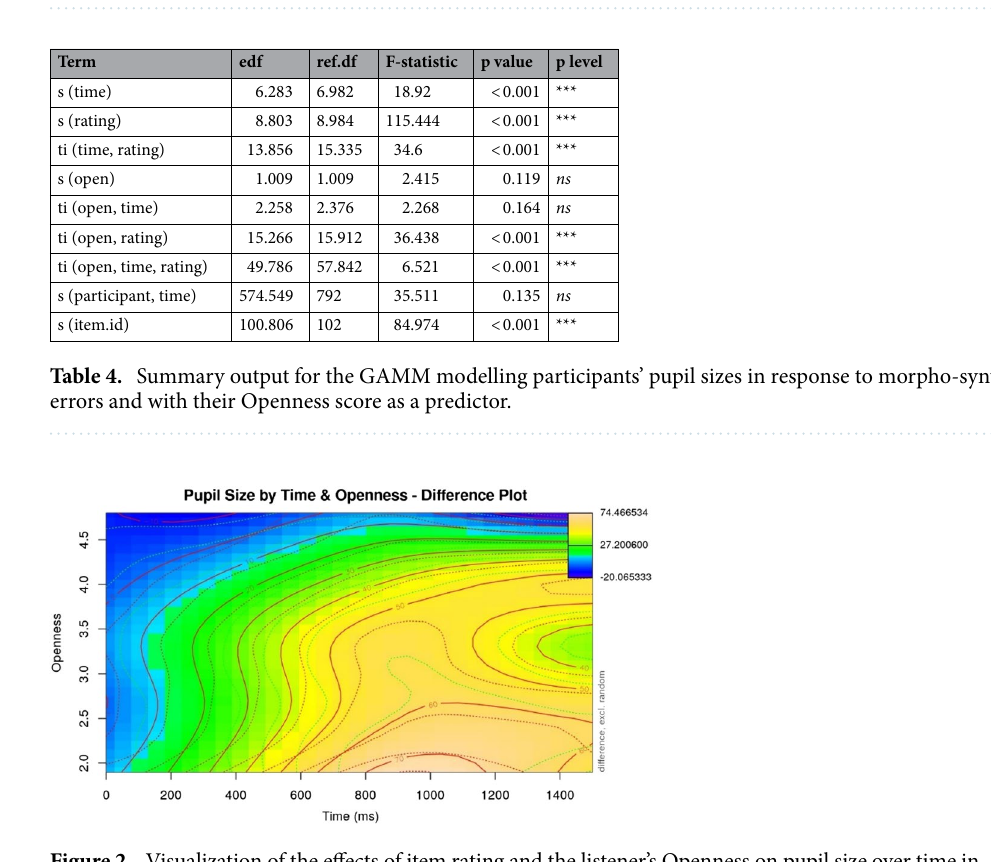
Figure 1. Visualizations of pupil size by item rating over time (in ms since target word onset). Panel A shows baseline (green/lower curve) vs. morpho-syntactic error condition (red/upper curve), and Panel B visualizes the difference between the two, with the red line on the x-axis (below the plot) highlighting the time frame where the difference in pupil size between the baseline and error conditions is significantly different. The shaded areas denote the 95% confidence interval.